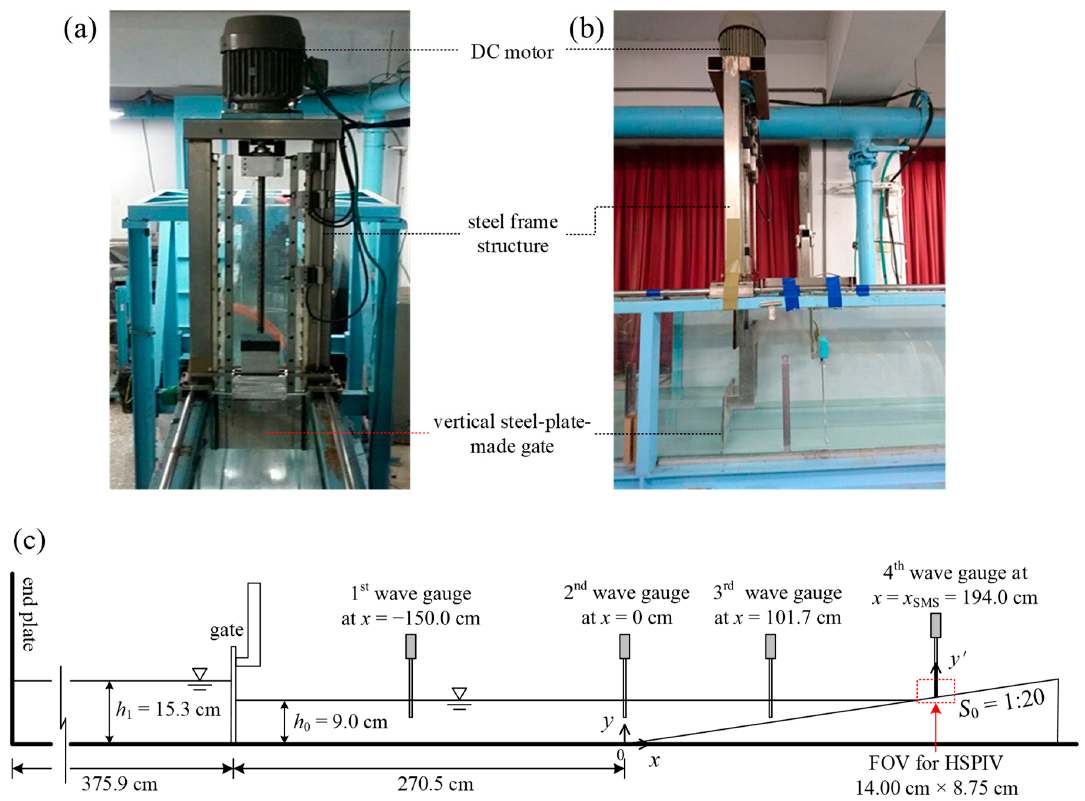
Figure 1. Photos showing the gate with its supporting steel frame structure mounted on the flume, ( a ) front view; ( b ) side view; ( c ) schematic diagram showing sloping beach model and coordinate system, together with installation of four wave gauges at x = − 150.0, 0, 101.7, and 194.0 cm as well as deployment of field of view (FOV) for high-speed Particle Image Velocimetry (HSPIV) measurements. According to Yeh and Ghazali [3], Yeh et al. [4], and Shimozono [5], an undular (or weak) bore